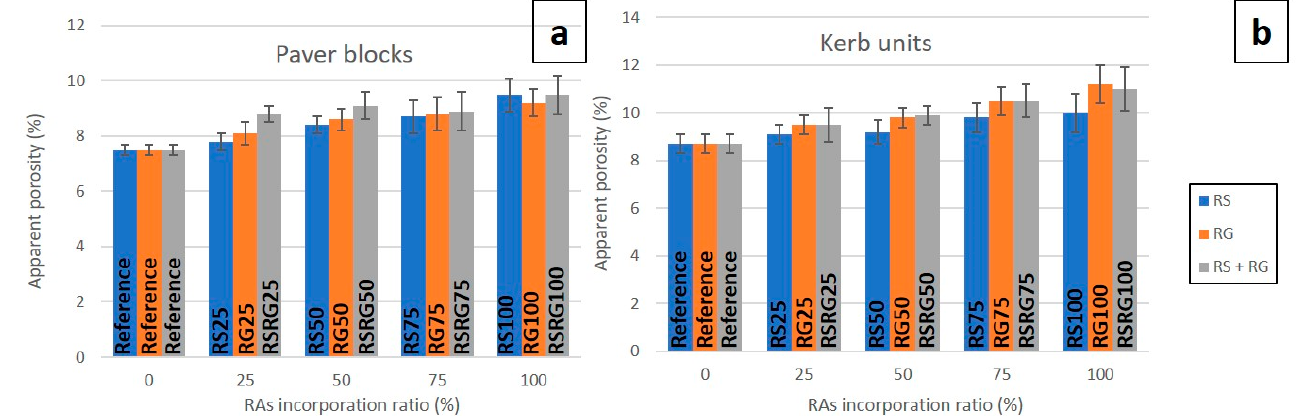
Figure 4. Graphical representation of apparent porosity vs. RAs’ incorporation ratio in pavers ( a ) and kerbs ( b ).